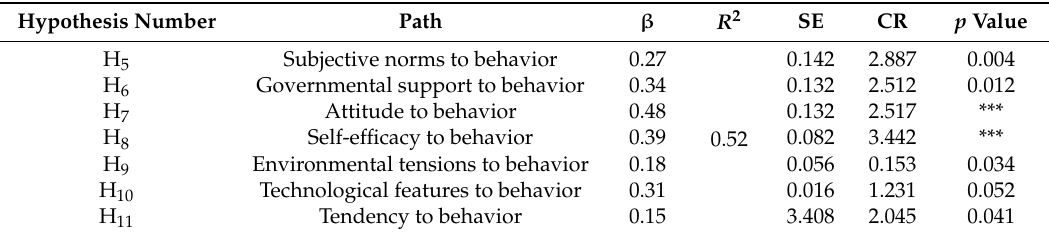
Table 6. Significance test of latent variables’ paths to behavior.